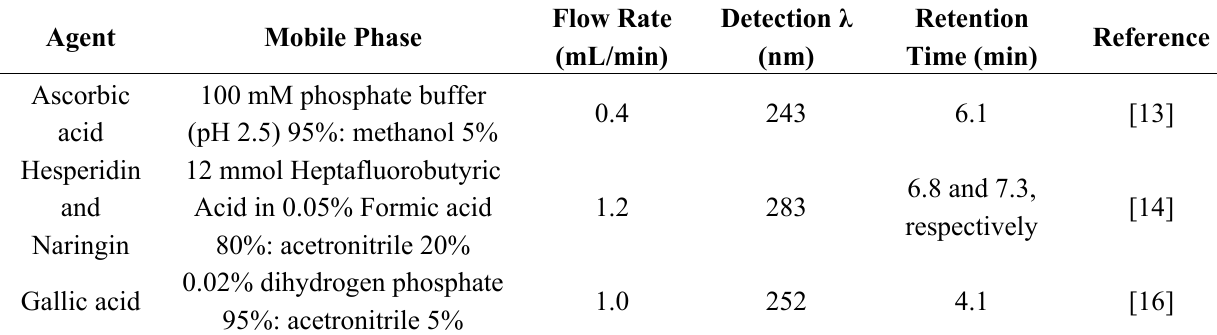
Table 1. Conditions for high performance liquid chromatography (HPLC) analyses of certain antioxidants in Citrus maxima (Burm.f.) Merr (CM).